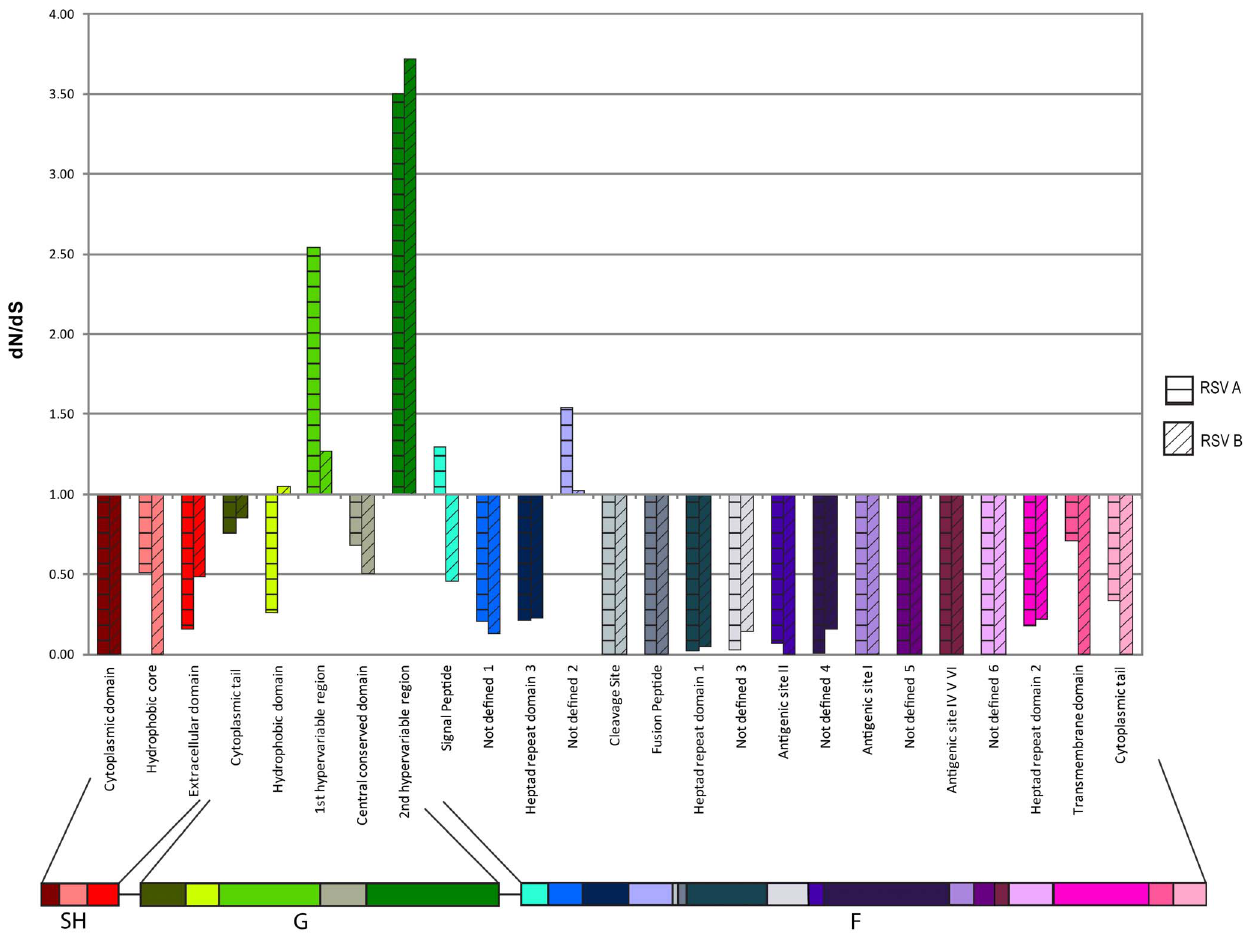
Figure 5. Amino acid variability according to domain in the SH, G and F genes. The non-synonymous/synonymous substitution ratio (Dn/ Ds) was calculated for each domain by the comparison between GA1, GA2 and GA5 genotype strains for HRSV-A and between GB3, GB4 and BA HRSV-B isolates. Ratio values . 1 are showing selection for variation between prototype (GA1) and contemporary viruses for HRSV-A and between dominant (BA) and contemporary viruses for HRSV-B.